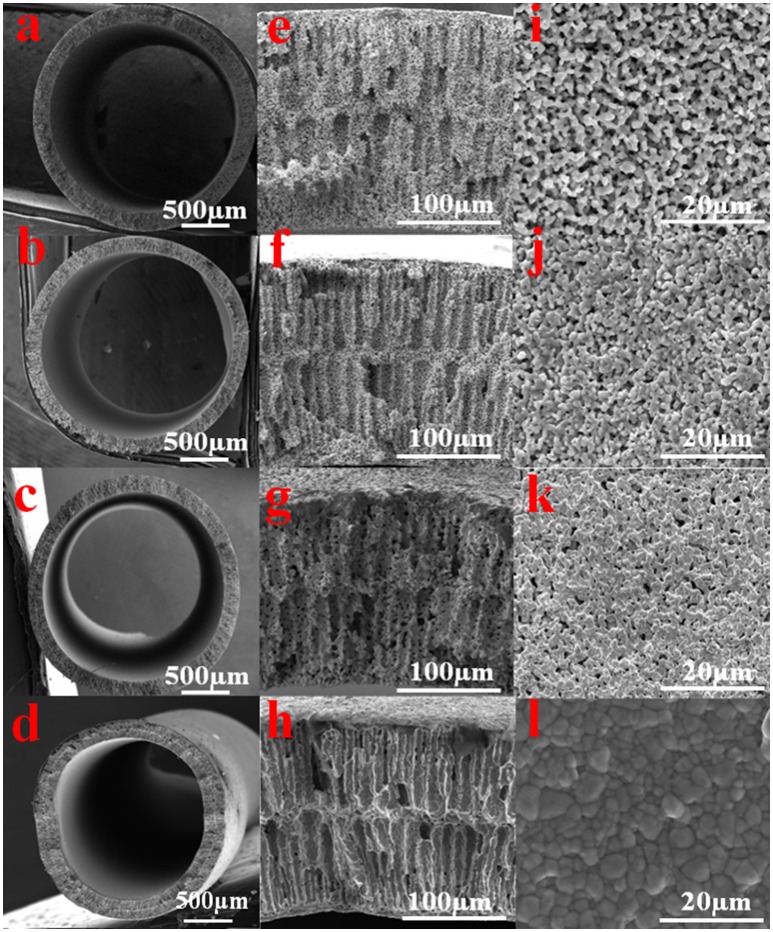
SEM images of the Cu-HFMs reductive sintered for 3 h in H2 atmosphere at different temperatures (a,e,i) 400°C; (b,f,j) 500°C; (c,g,k) 625°C and (d,h,l) 700°C. (a–h) for cross sectional; (i–l) for outer surface.